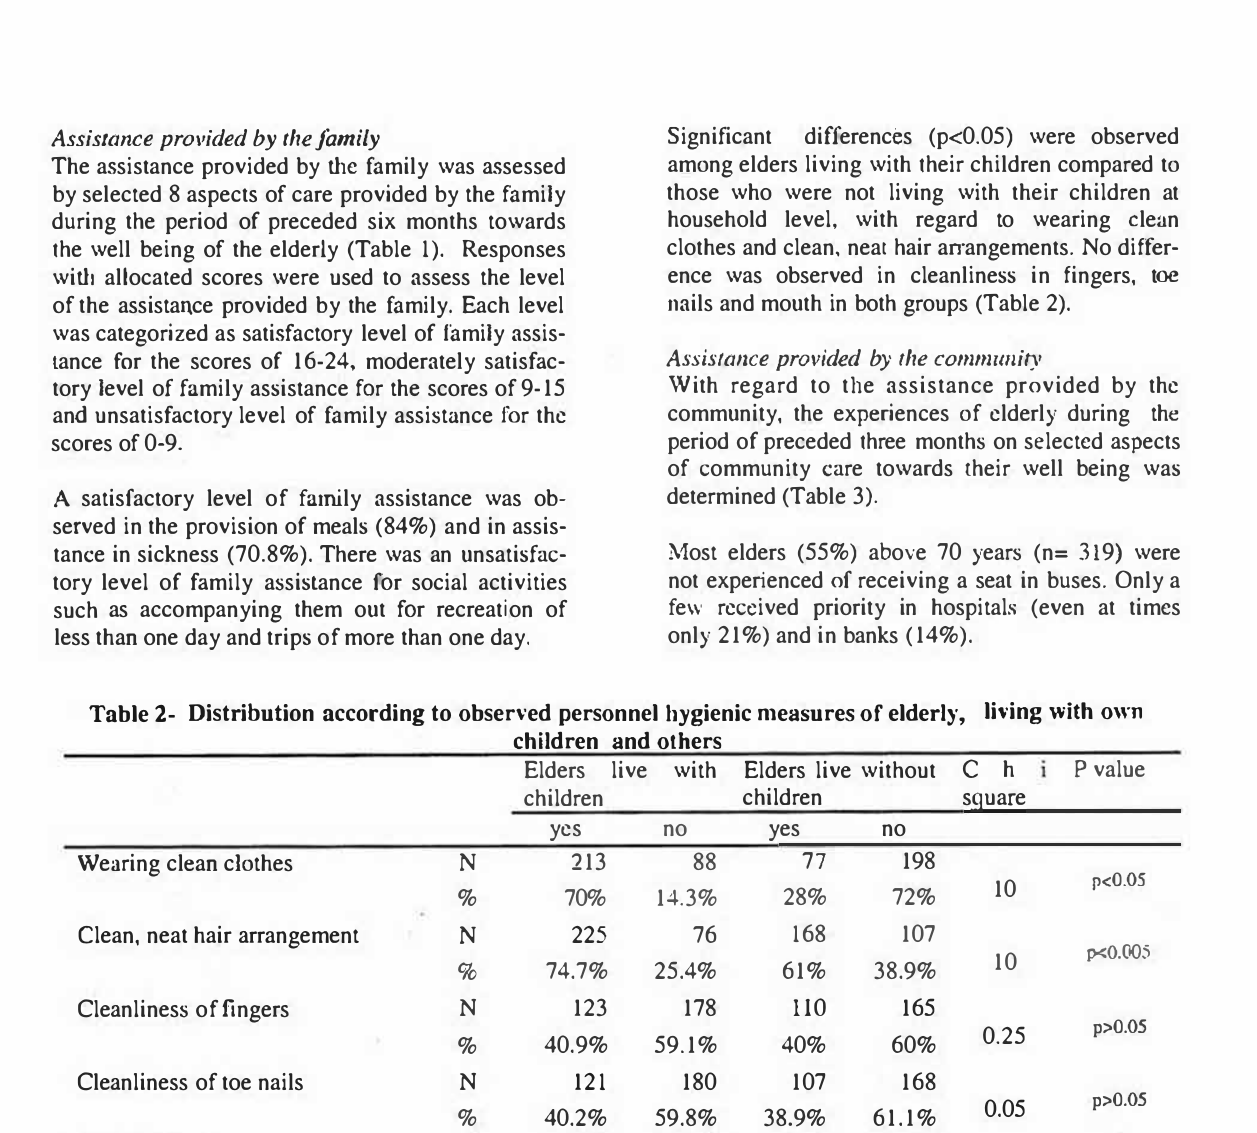
Table 3-Distributio11 of elders accordi11g to the exeeriences of communit;i: